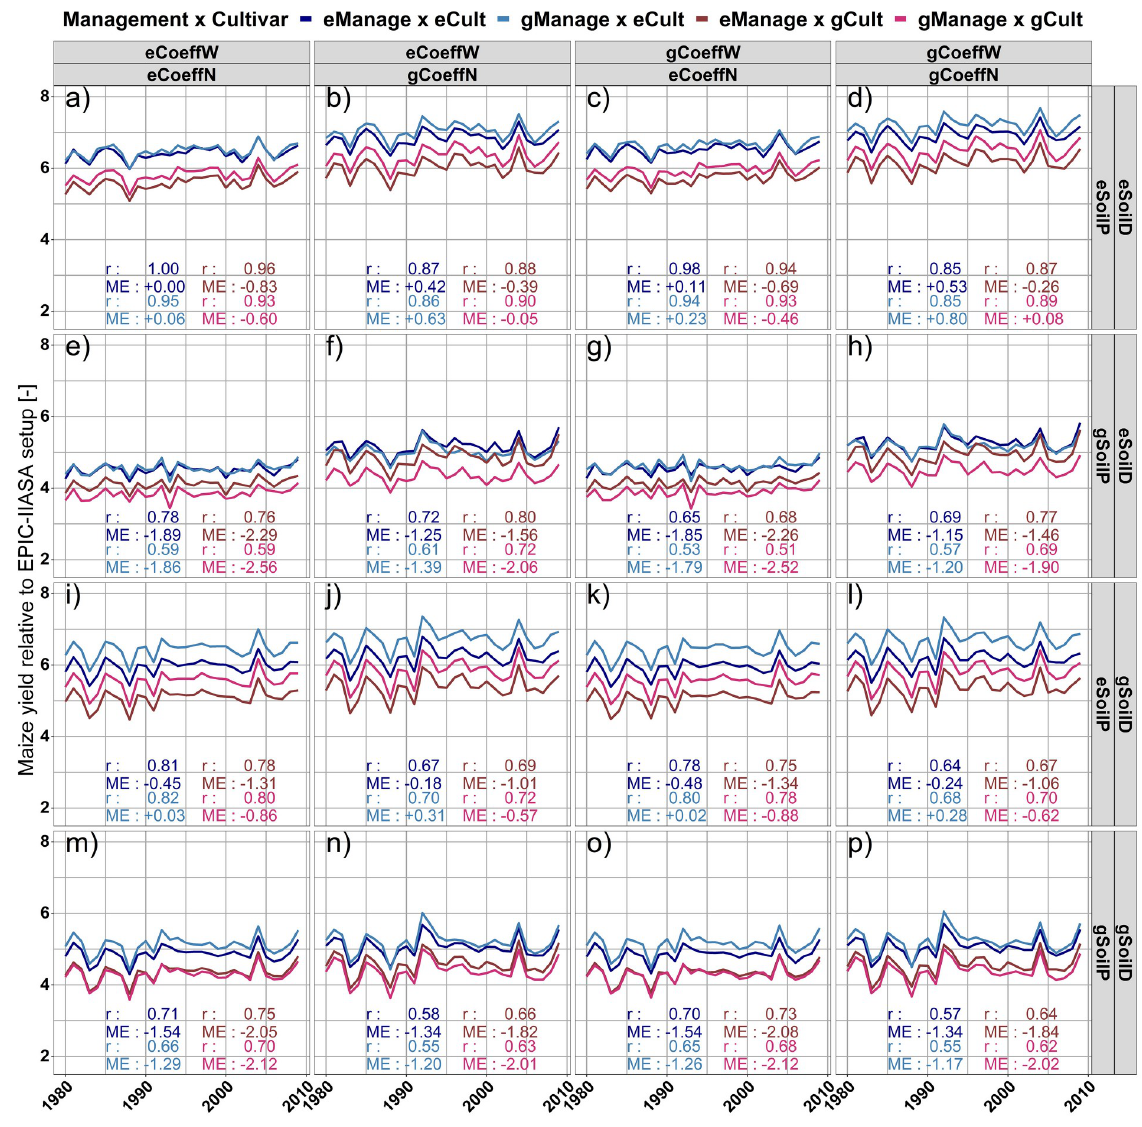
Fig 7. Relative difference in global average rainfed maize yields over a 29 year period for 64 setup combinations. Setup domains are introduced from GEPIC into the EPIC-IIASA setup (Table 3) and compared to the original EPIC-IIASA configuration. e = EPIC-IIASA, g = GEPIC, Cult = cultivar definition and distribution, SoilD = soil parameters, SoilP = spin-up and soil handling, CoeffN = organic matter and nutrient cycling coefficients, CoeffW = hydrologic coefficients, Manage = crop management. CV t = coefficient of variation over time normalized to mean = 1. ME = mean error compared to the full EPIC-IIASA setup. Corresponding absolute yields are provided in Fig N in S1 File.